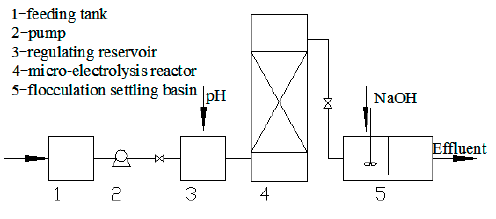
Figure 1. Continuous micro-electrolysis reactor.